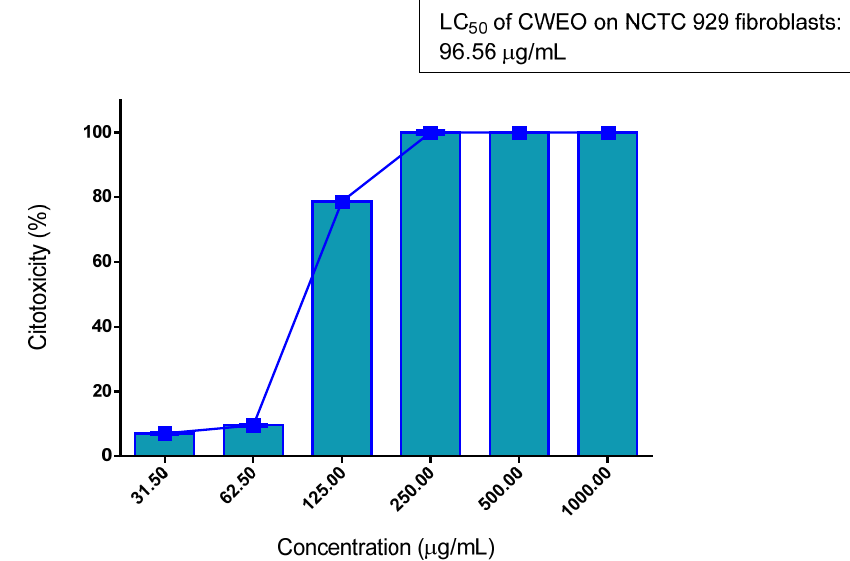
Figure 2. Cytotoxicity of the essential oil of C. winterianus , with the confidence interval for oil at 95% (87.07–107.10). LC 50 was obtained through non-linear regression of means. According to Figures 3 and 4, the EOCw presented inhibition values considered very promising for the promastigote and epimastigote forms of L. brasiliense and T. cruzi , with LC 50 values of 44.98 μ g/mL and 72.60 μ g/mL, for Leishmania and Trypanosoma , re- spectively, with performance equivalent to that of Pentamidine, at a concentration of 125 μ g/mL.